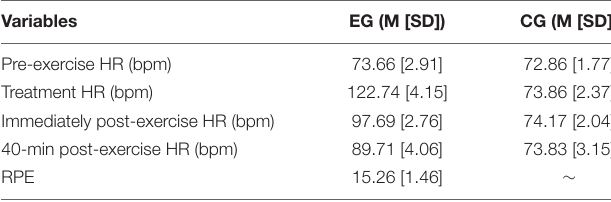
TABLE 2 | Descriptive data for the exercise manipulation